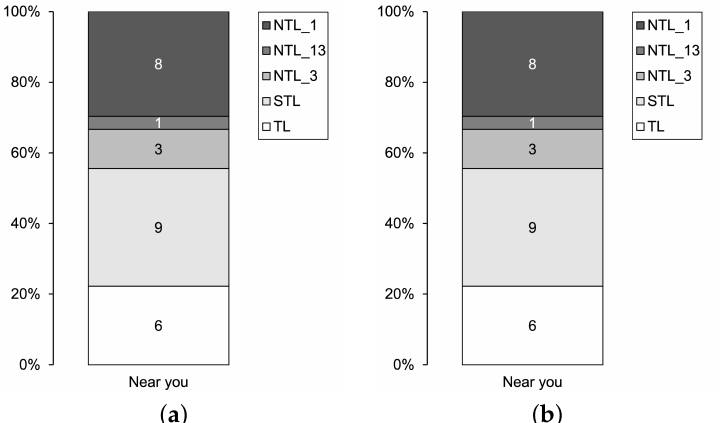
Figure 3. Hearer-related deictic domain: fine-grained results for picture sentence matching task ( a ) and semi-guided production ( b